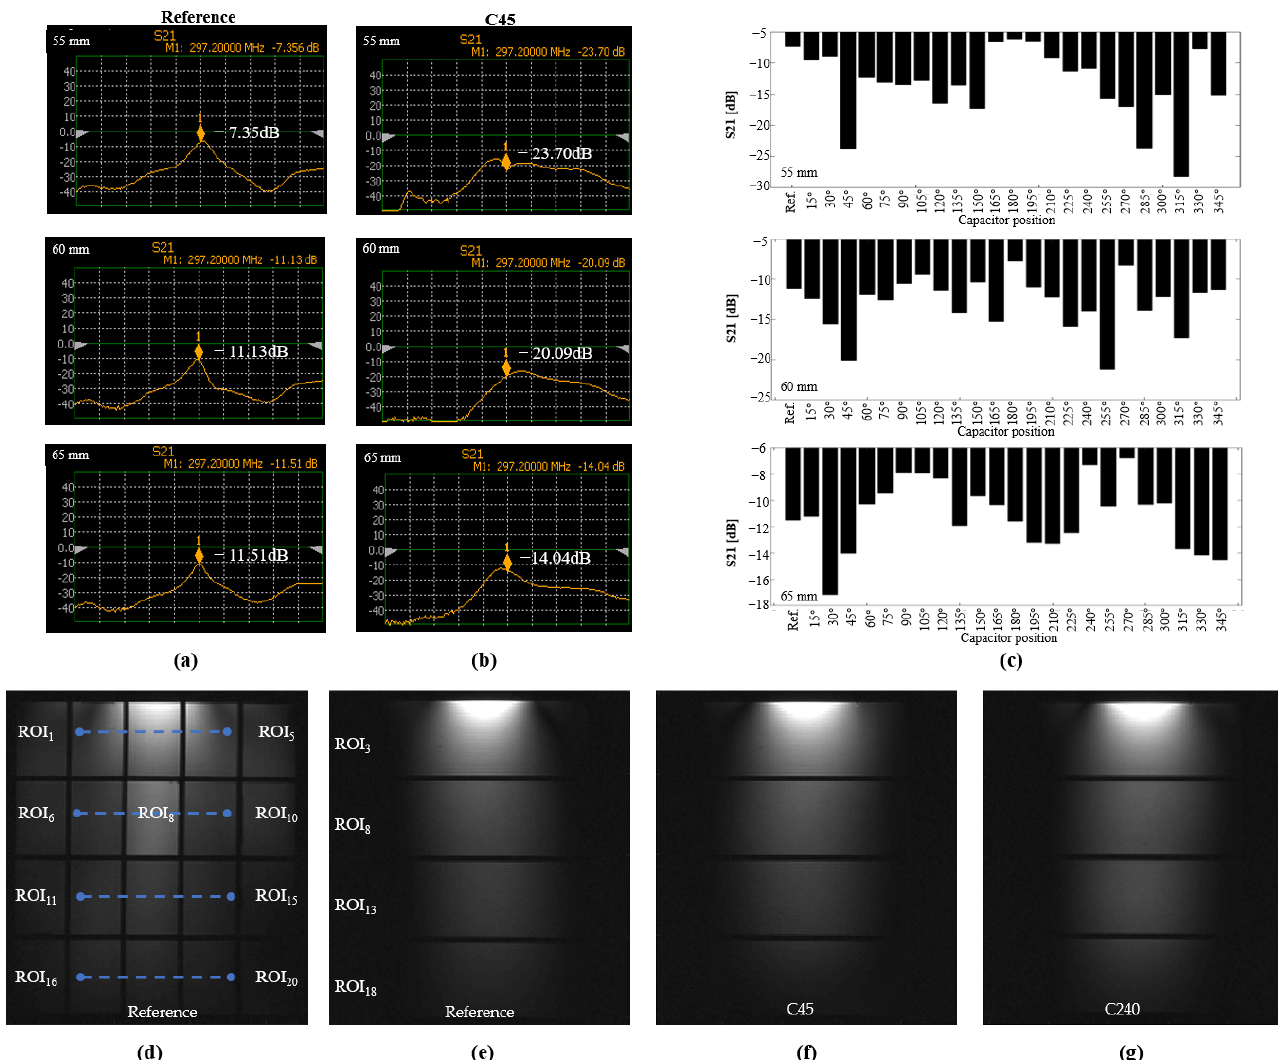
Figure 12. ( a ) S 21 parameters from network analyzer for reference coil, ( b ) C45, and ( c ) S 21 parameters for all tested coil configurations at 297.3 MHz, for coil separation distances of 55, 60, and 65 mm, shown in top, middle, and bottom panels, respectively. Acquired GRE MRI images in axial ( d ) and sagittal views, for ( e ) reference coil, and coils with capacitors at ( f ) 45° and ( g ) 240°.